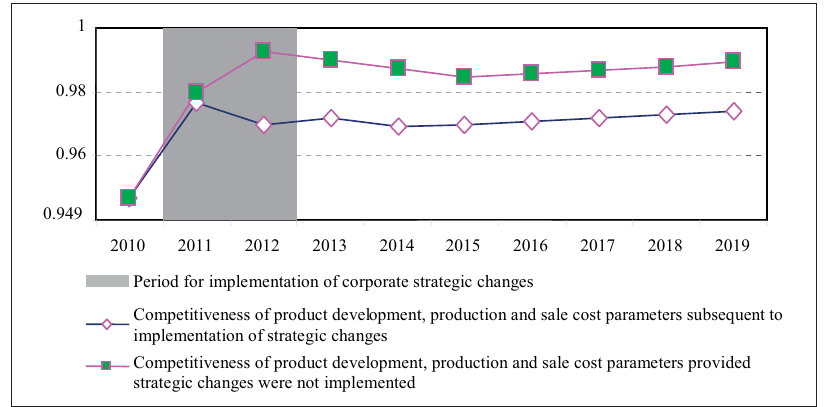
Fig. 2. Dynamics of the cumulative competitiveness index (γ